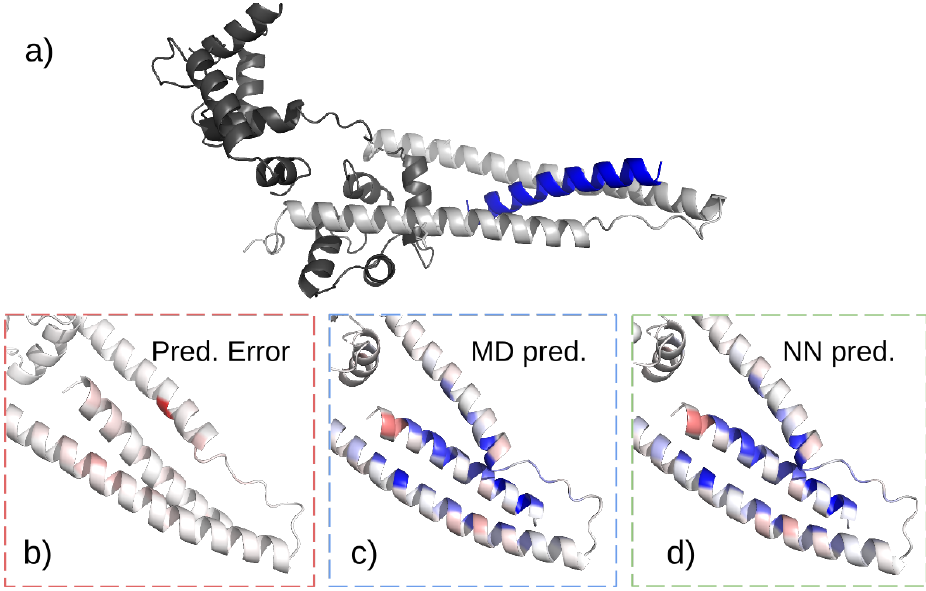
Figure 2. Structure of the Troponin complex. ( a ) Ribbon representation of a modified Troponin complex. Using a fragment of Troponin T (blue) as a template, the design of a binder for Troponin I (light gray)-Troponin C (dark gray) complex can be optimized. ( b ) Mean normalized energy prediction error (white_red spectrum, red indicates large errors) between MD prediction (panel ( c )) and NN prediction (panel ( d )), (both panels are blue_white_red spectrum, blue indicates negative energy values). Note that the overall error is low, as indicated from the minor color difference representing the energy predictions even where the difference (normalized) is the most significant. This means the model can be used for